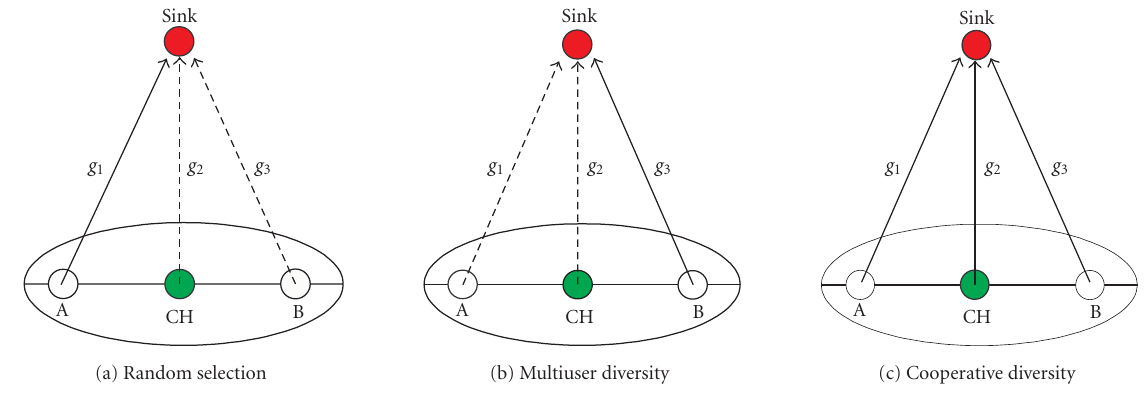
Figure 4: Data transmission schemes from a coalition to the